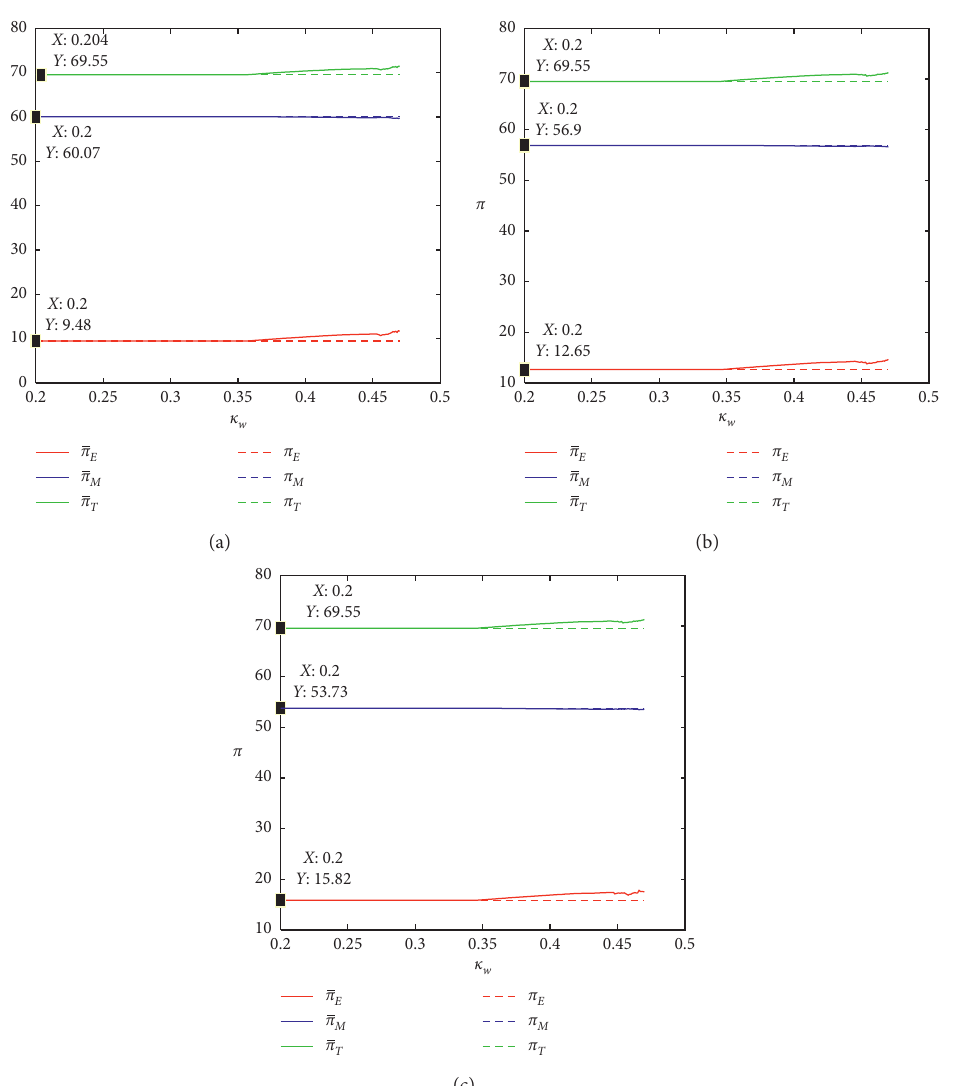
� 0 . 1. (b) δ � 0 . 2. (c) δ � 0 . w under different δ . (a) δ